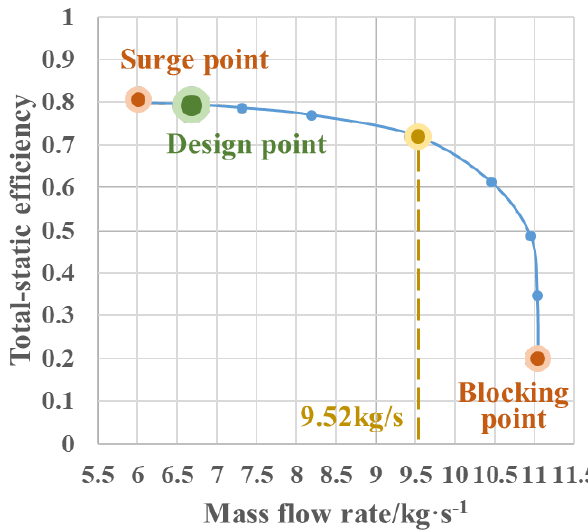
Figure 21. The compressor mass flow rate-total static efficiency curve.